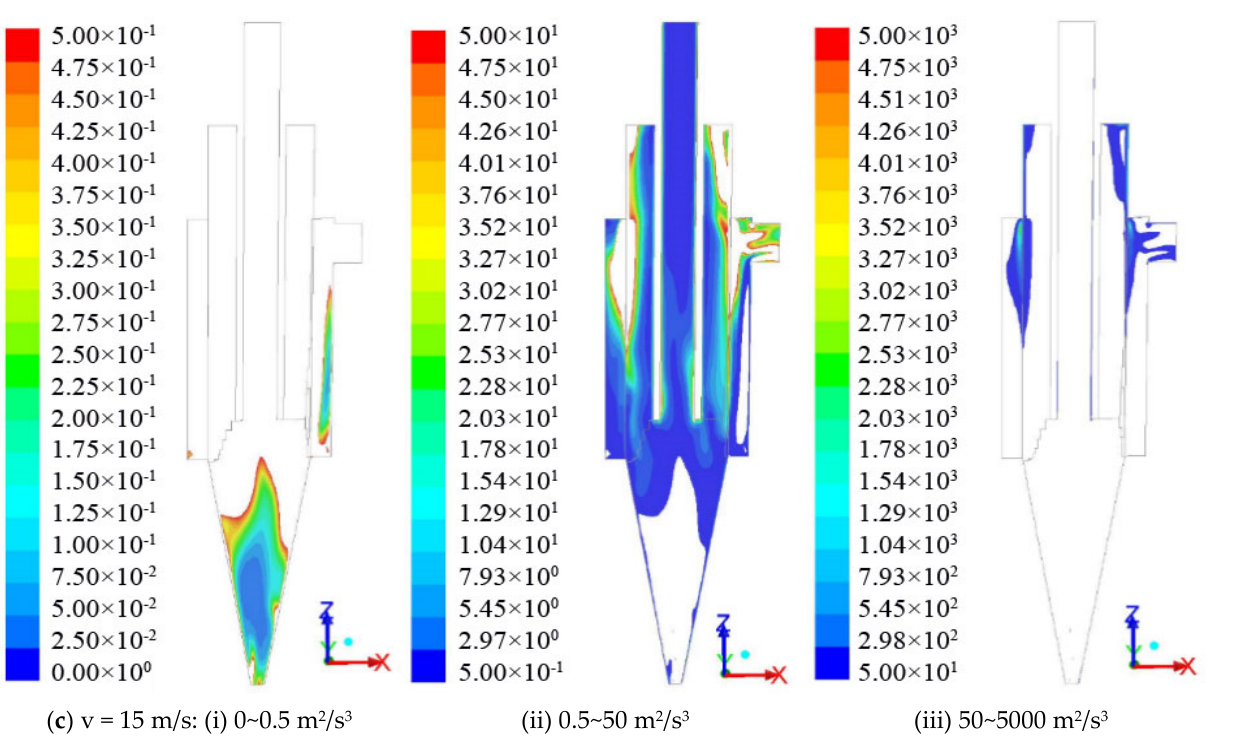
Figure 8. Distribution of turbulence dissipation rate ε (m 2 /s 3 ) in TPHS. In Figure 8b, (i) 0~0.1 m 2 /s 3 (ii) 0.1~1 m 2 /s 3 , and (iii) 1~10 m 2 /s 3 show the distribution